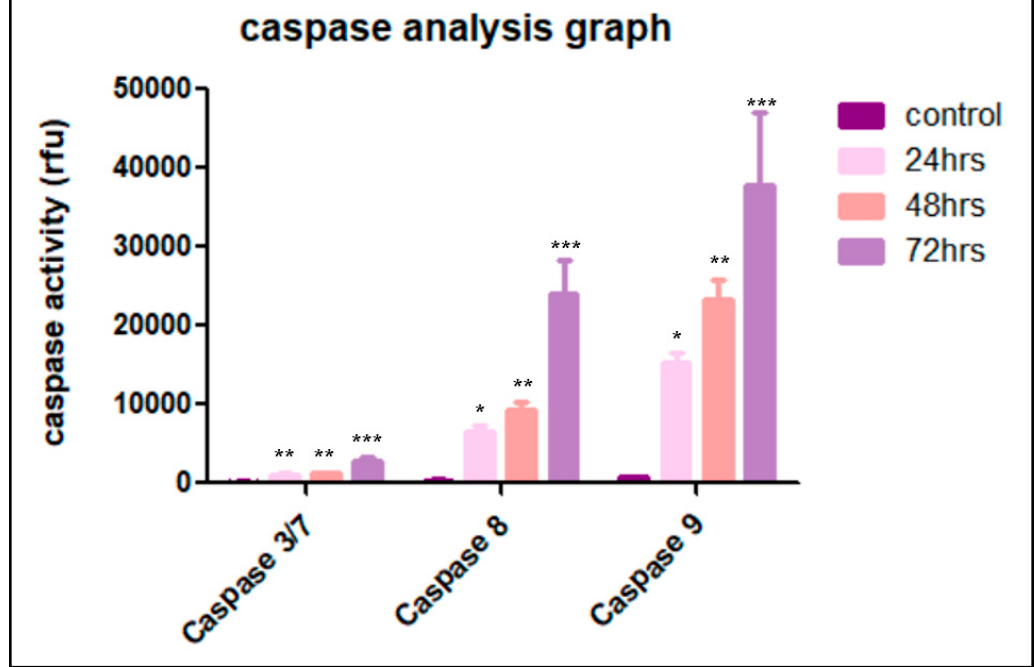
Figure 5. Caspases 3/7, 8 and 9 activity levels in CADMN–treated HepG2 cells estimated